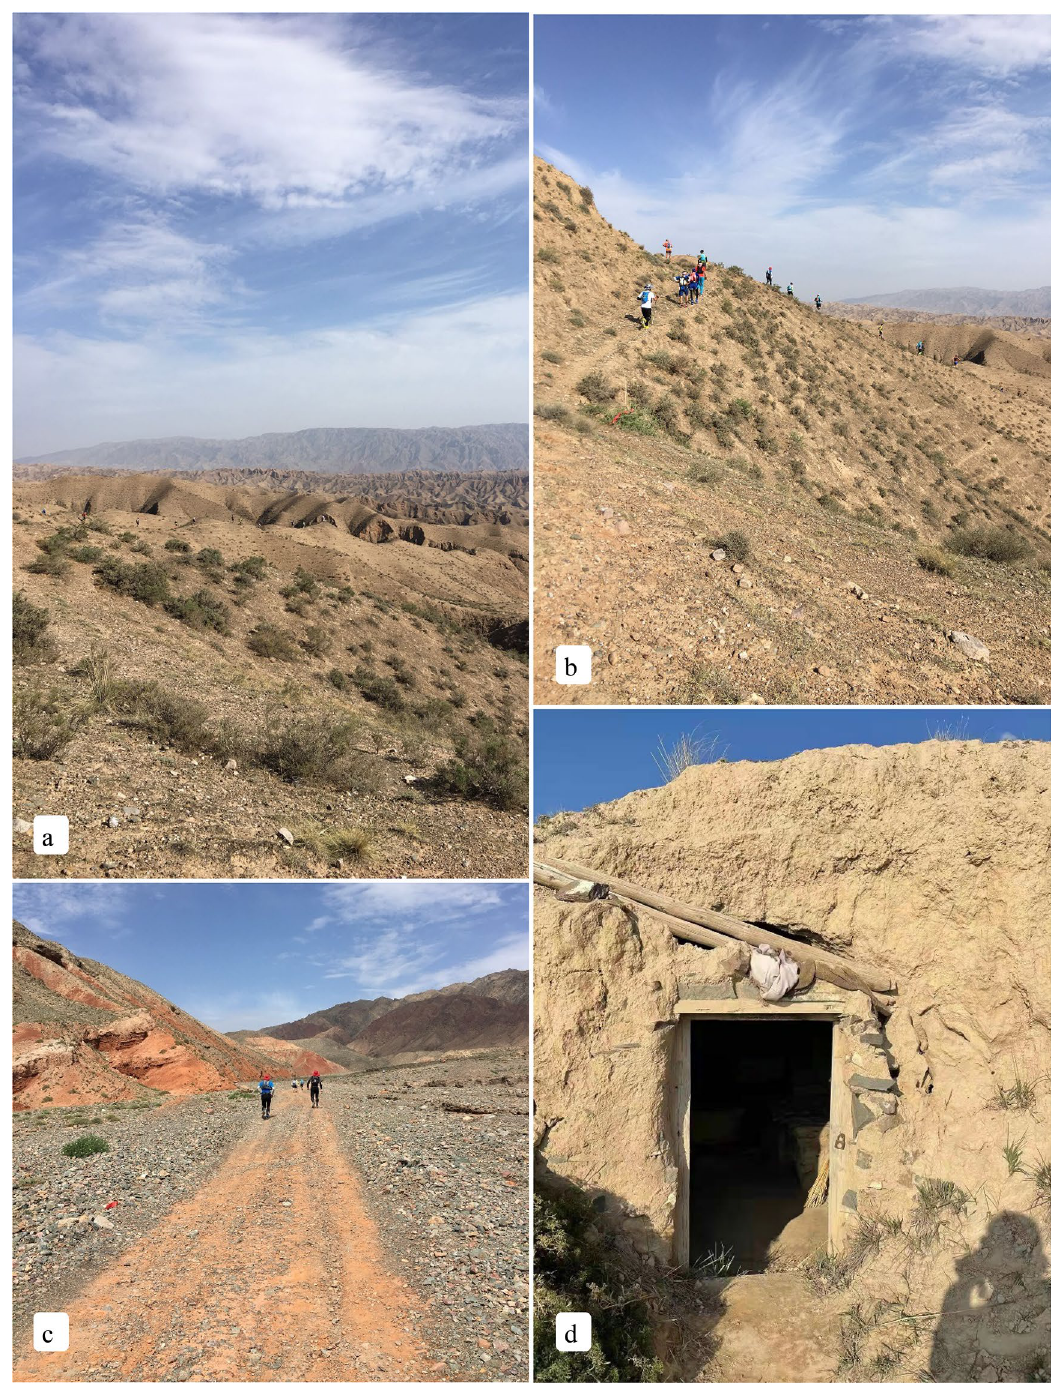
Figure 2. Baiyin marathon photos of pre-race, disaster, and rescue. ( a – c ) Baiyin marathon on May 20, 2018. ( d ) cave-dwelling, some runners were warming themselves by the fire on May 22,